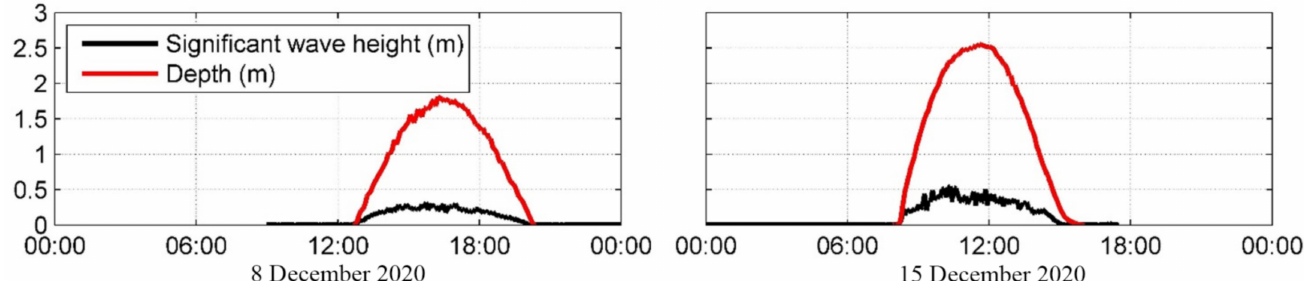
Figure 16. The significant wave height and water depth measured during a flood–ebb tide period on 8 December 2020 ( left panel ) and 15 December 2020 ( right panel ). The wind conditions of the former and later measurements were normal condition (less than 5 m/s) and strong wind (more than 10 m/s). The location of the wave station is shown in Figure